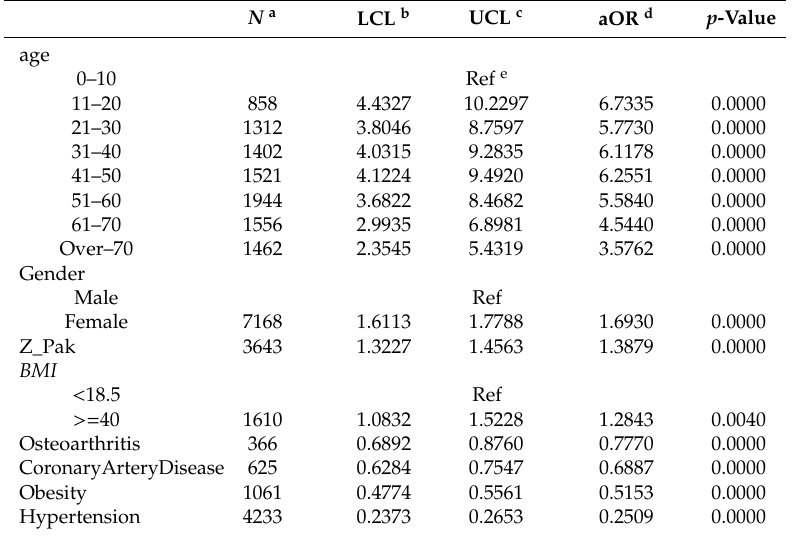
Table 3. Association of dietary supplements, antibiotics, and comorbidities for depression.